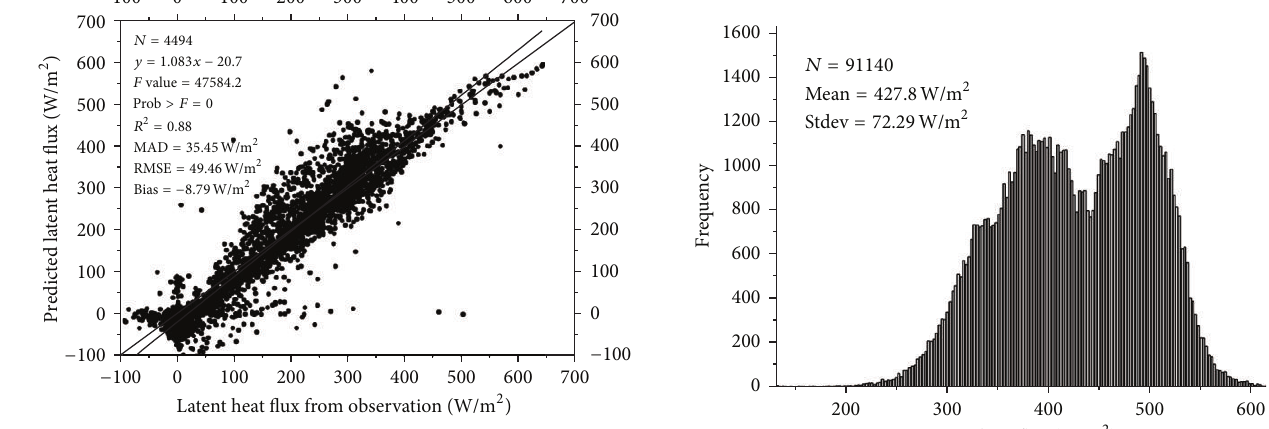
Figure 5: Model predicted latent heat flux (W/m 2 ) versus eddy covariance based observations for all soybean sites from DOY171- 190, 2002.